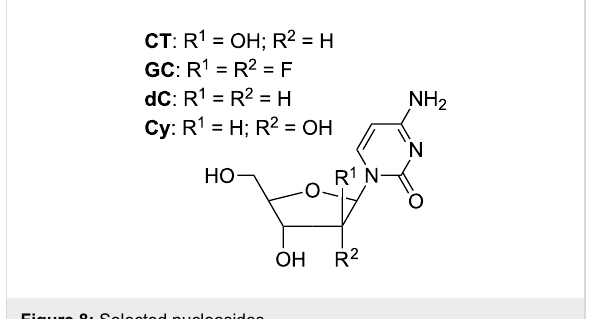
Figure 8: Selected nucleosides.